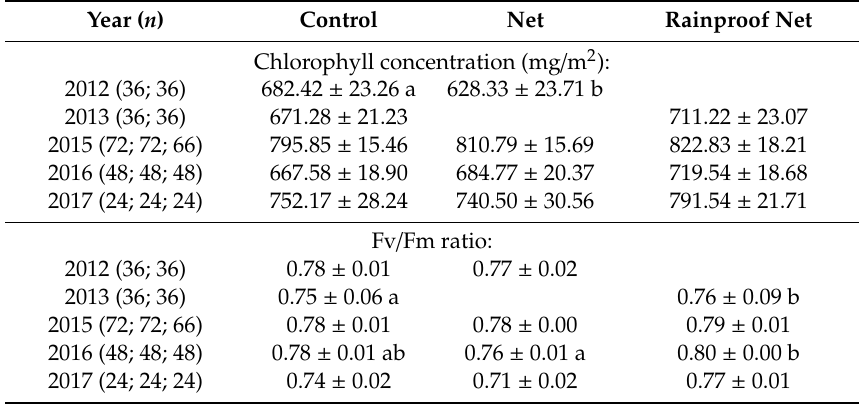
Table 2. Chlorophyll concentration and fluorescence ratio (mean ± SE, n = total number of observations) for apple leaves collected from row units without nets, with exclusion nets and with rainproof exclusion nets. Di ff erent letters indicate statistically significant di ff erences between treatments for appropriate years (Tukey tests p <